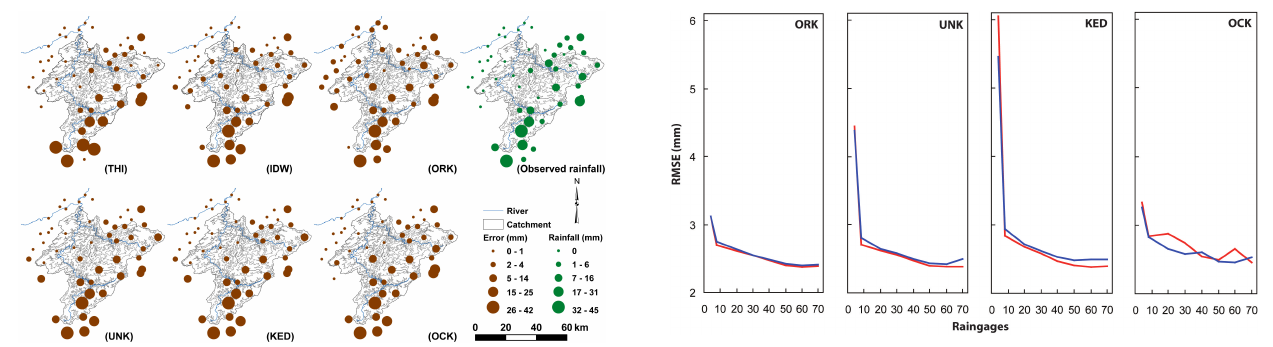
Fig. 13. Absolute error and observed rainfall maps for a day of summer (14 July 1994). The background is the contour line of the catchments.